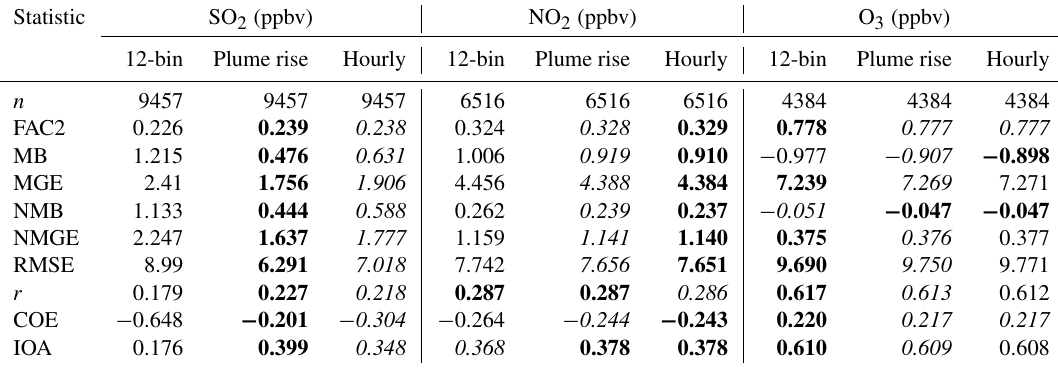
Table 5. Statistical comparison of SO 2 , NO 2 , and O 3 surface volume mixing ratio measurements from the WBEA surface observation network with the 2.5km resolution GEM-MACH simulations between 10 August and 10 September